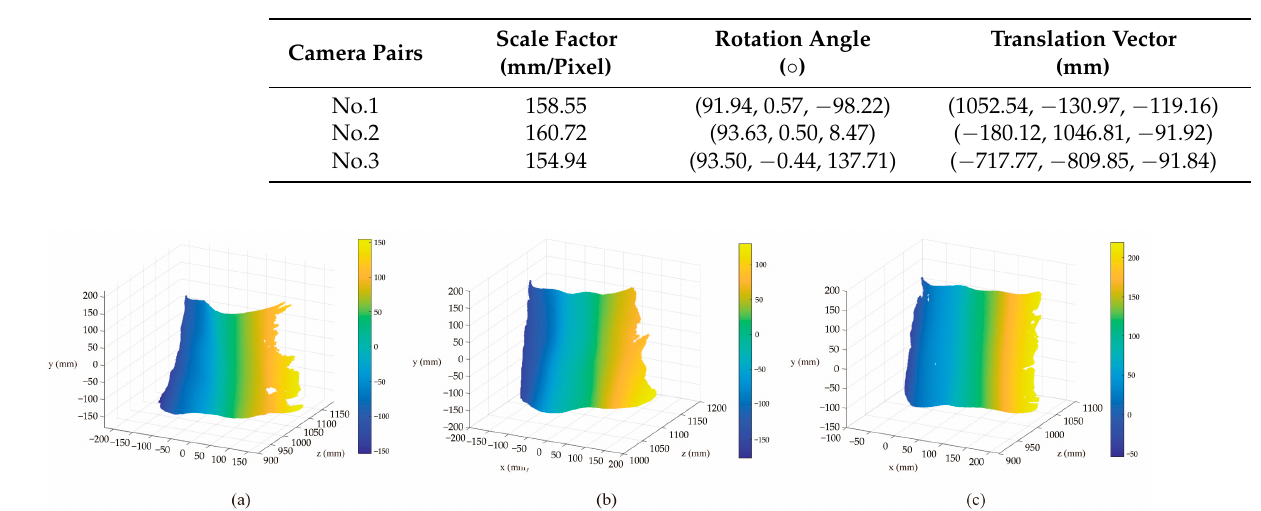
Table 3. Scale factor, relative rotation and translation vector determined in the measurement.